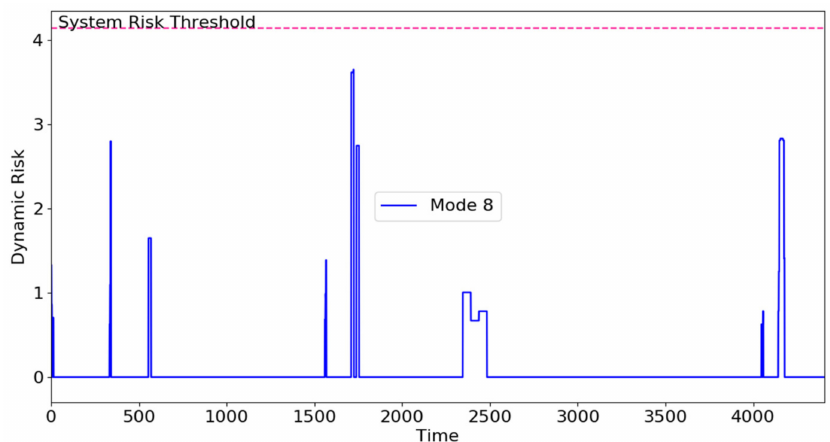
Figure 11. Normal execution sequence of the insulin pump operating in the highest mode, M 8